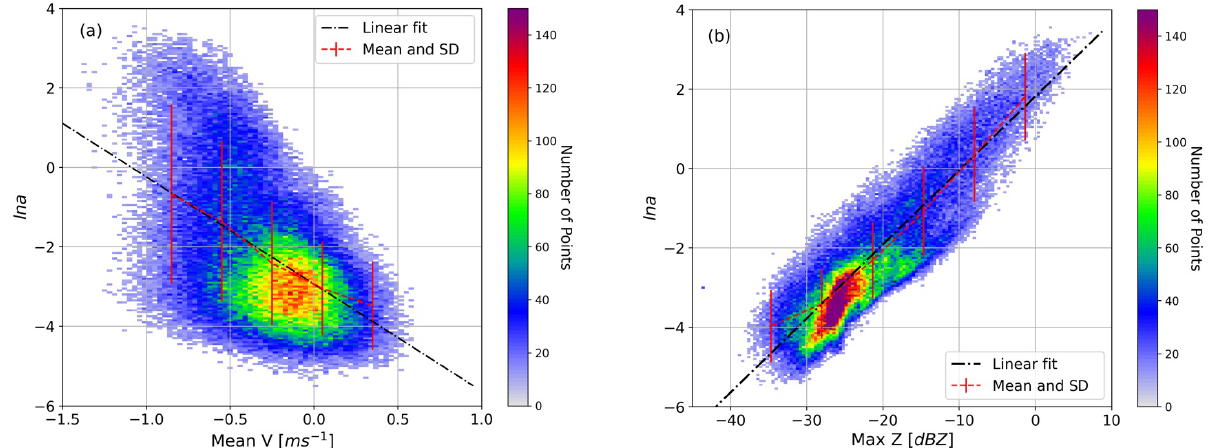
Figure 13. Correlation of (a) mean velocity versus ln a and (b) maximum reflectivity versus ln a for cloud profiles, where the color bar indicates the number of profiles.